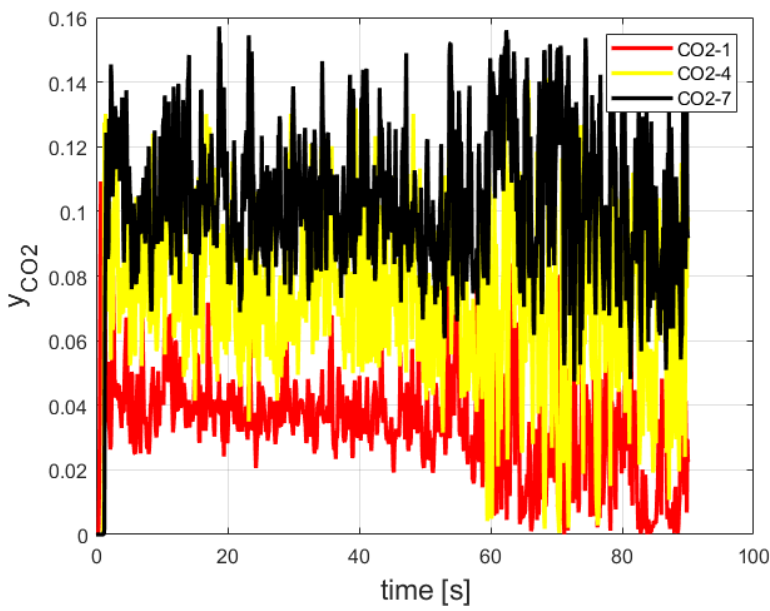
Figure 8. Carbon dioxide readings of three sensors inside the